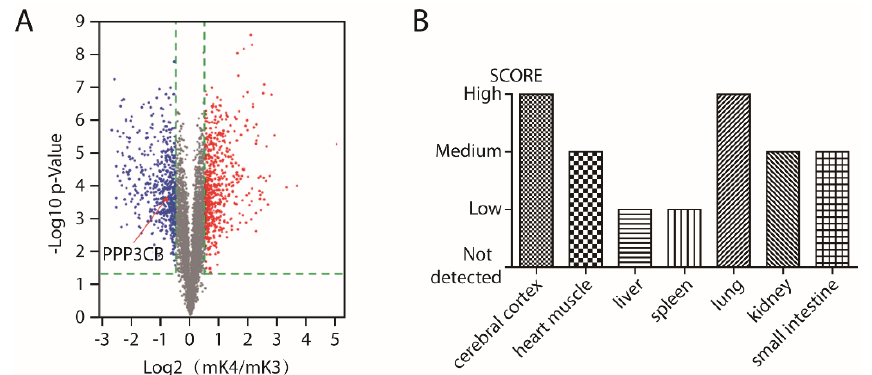
Figure A1. The expression of PPP3CB in mouse kidney cells and various normal human cells. ( A ) Differentially expressed proteins are selected by volcano plot filtering ( p -value ≤ 0.05). Volcano plot shows high expression of PPP3CB in mK3. ( B ) The analysis results of PPP3CB expression in various normal human cells using the open source The Human Protein Atlas (http://www.proteinatlas.org/). Mouse-over function shows protein score for analyzed cell types in a selected tissue.